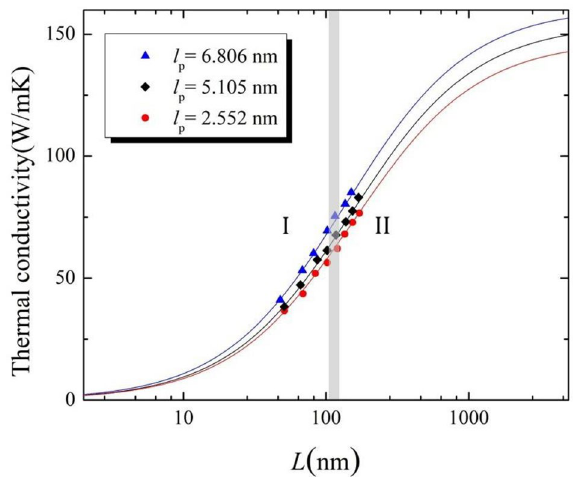
Figure 4. Thermal conductivity as a function of total length for graphene/graphane superlattice nanoribbons using various superlattice periods of l p = 2.552, l p = 5.105 nm, and l p = 6.806 nm at T = 300 K and ΔT = 40